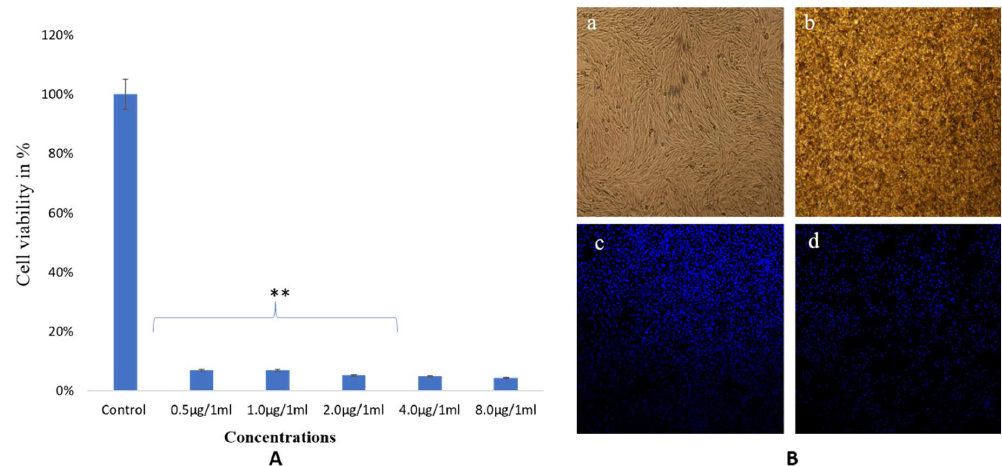
Figure 10. Cell viability by MTT Assay. The HCT-116 cells treated with di ff erent concentrations of TiO 2 NPs after 48 h ( A ). Cell morphology of HCT-116 cells on treatment with TiO 2 NPs ( B ). ( a ) control and ( b ) treated with 8.0 µ g / mL, analyzed by a light microscope. ( c ) Control and ( d ) treated 8.0 µ g / mL analyzed by a confocal scanning microscope. Di ff erence between two treatment groups were analysed by student’s t test where ** p < 0.01.